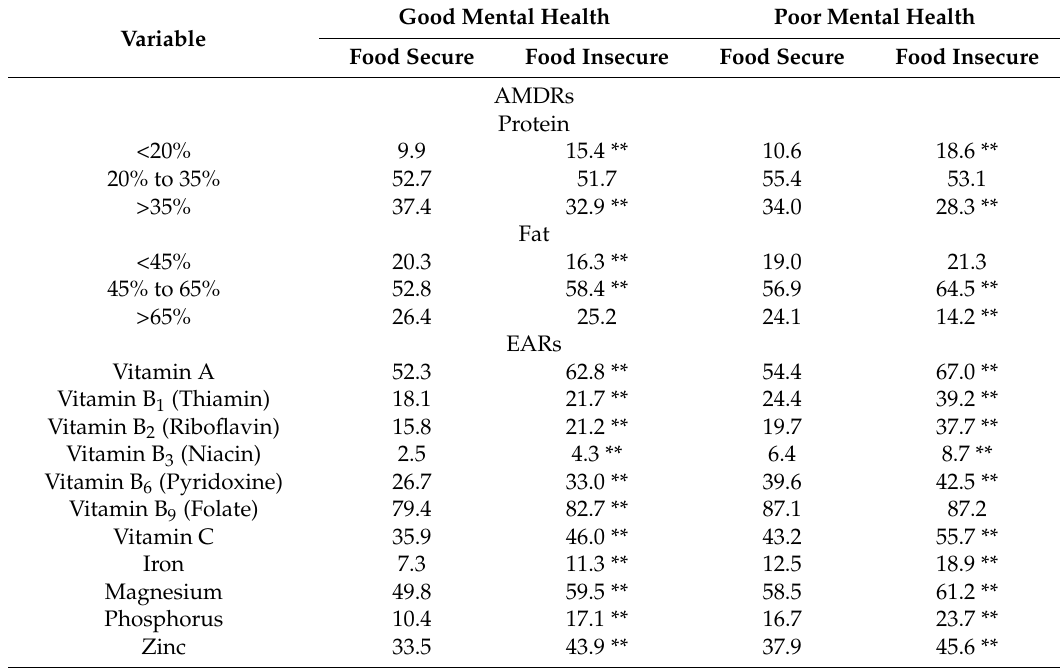
Table 1. Prevalence estimates for categories of the acceptable macronutrient distribution ranges (AMDRs) and estimated average requirements (EARs) by mental health and food security a .